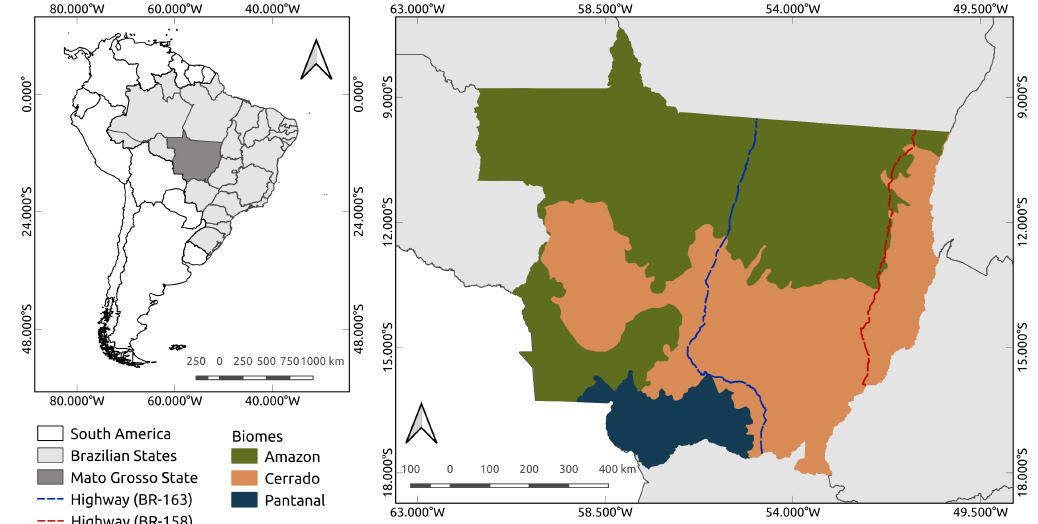
Figure 1. Mato Grosso State, Brazil. The Amazon biome occupies 54% of state, mostly in the north and some in its west part; the Cerrado covers 39.5% expanding from east to west through the center of the state; and the Pantanal in the southwest